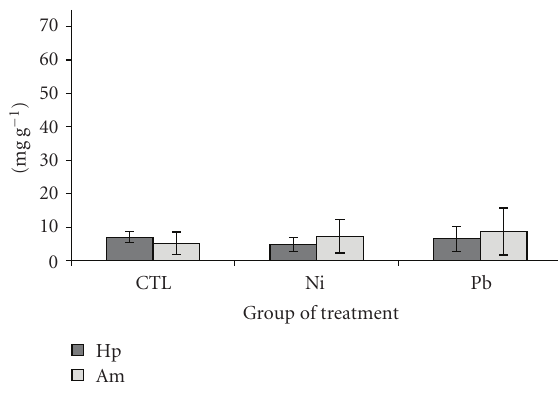
Figure 3: Glycogen concentration (mgg − 1 ; mean ± sd) in hep- atopancreas (Hp) and abdominal muscle (Am) of Penaeus van- namei after 10 days of treatment. ∗ Significantly di ff erent from control ( P < .